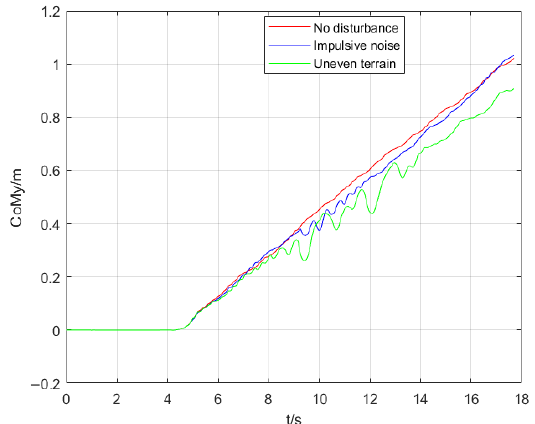
Figure 8. Displacement in the sagittal plane of the CoM.